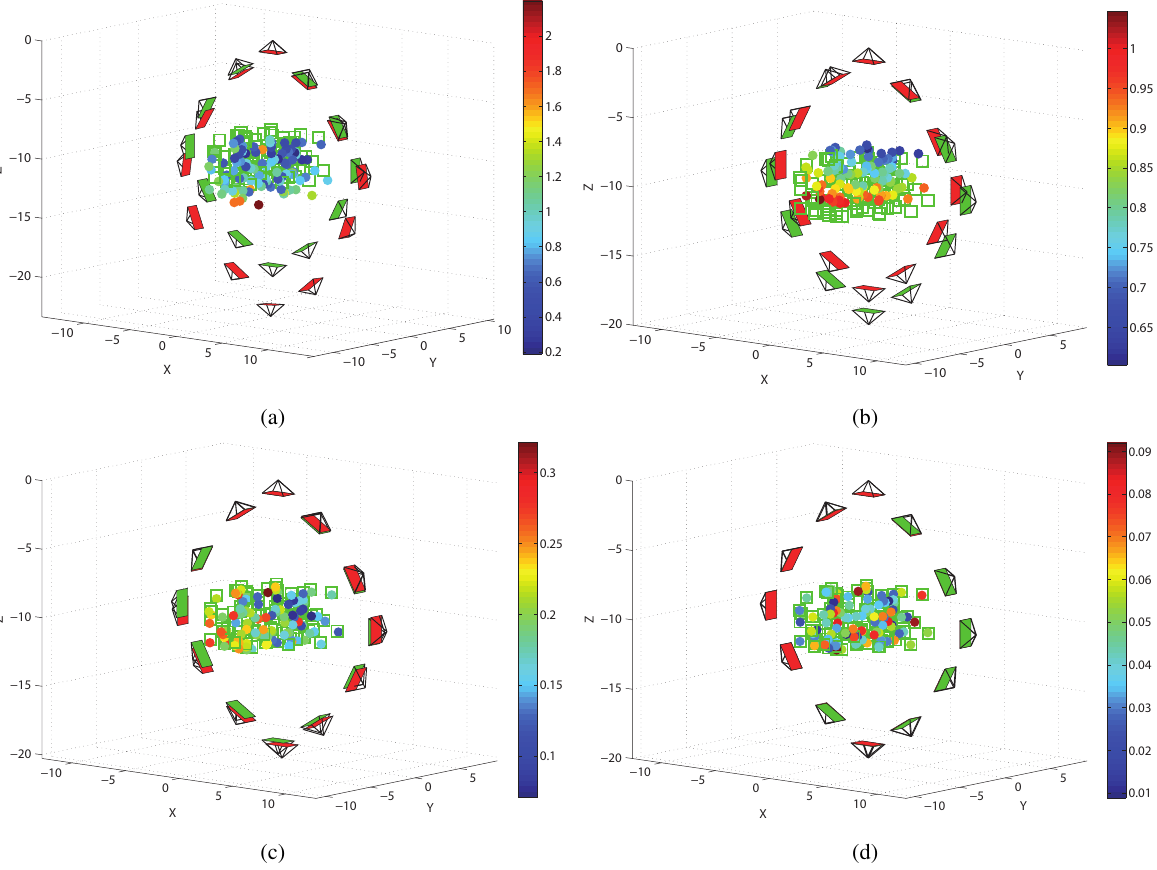
Figure 3: Circular arrangement of images and randomly distributed object points. The green images and the green squares depict the ground truth. The red images and the coloured points show the results of the following stages: initial values from projective geometry (3a), solution of convex estimation of translations and object points without rotation averaging (3b), solution after multiple rotation averaging and convex estimation of translations and object points (3c) and solution of a robust bundle adjustment (3d) using the initial values depicted in (3a). The points are coloured with respect to their distance to the ground truth. Note that the color scale is different in every